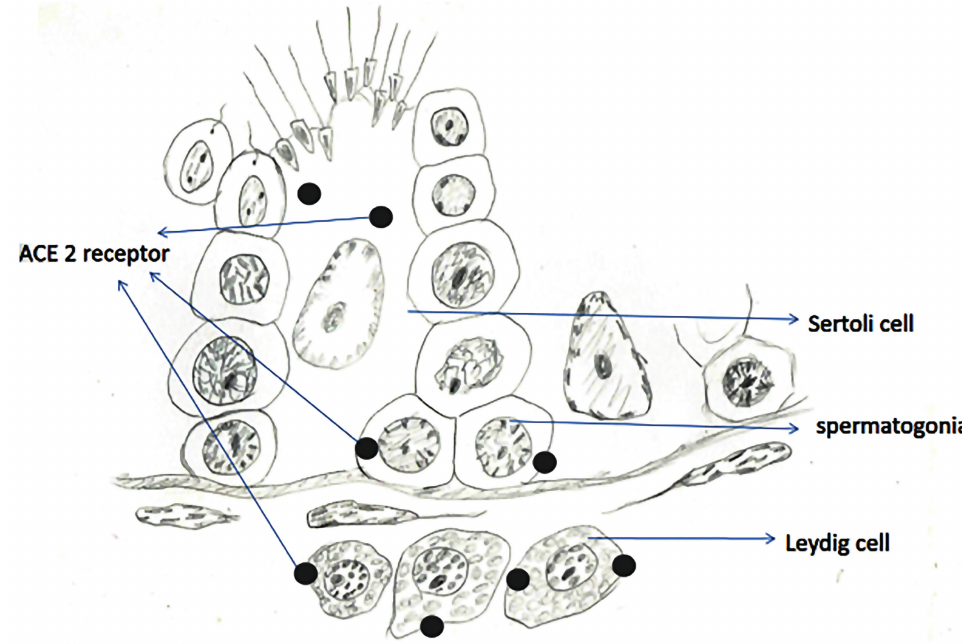
Figure 1 - Scheme depicting the location of ACE2 receptor, a target for SARS-CoV-2 infection, in testicular